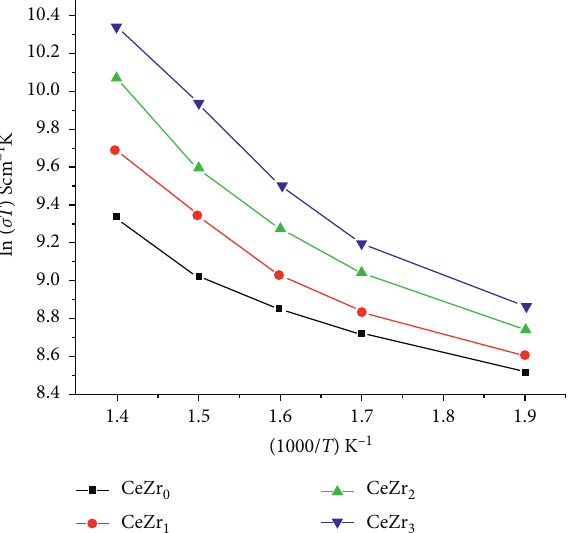
Figure 3: Electronic conductivities of all four samples CeZr